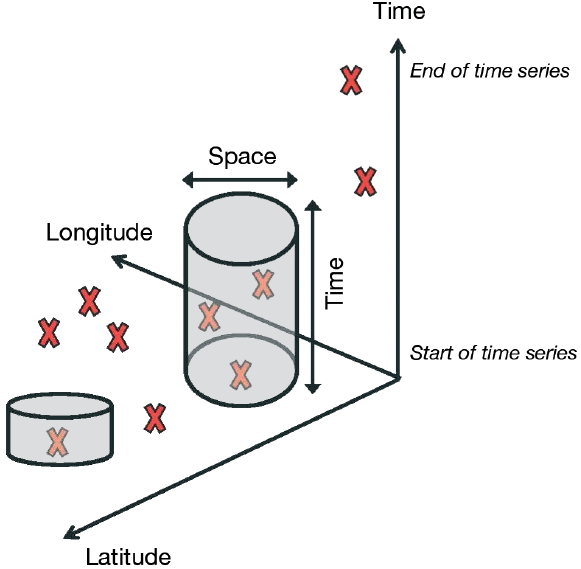
Fig. 2. Schematic illustration of how SaTScan analysis scans through spatio-temporal data (red ‘X’s) with scanning win- dows of varying sizes (grey cylinders) to identify clusters. Illustration is an adaptation of a figure from Ahmadkhani et al.